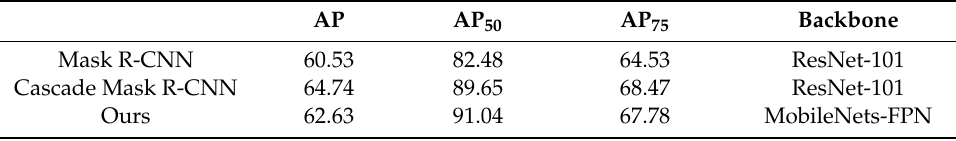
Table 4. Comparison of mean average precision (mAP) results in instance segmentation.